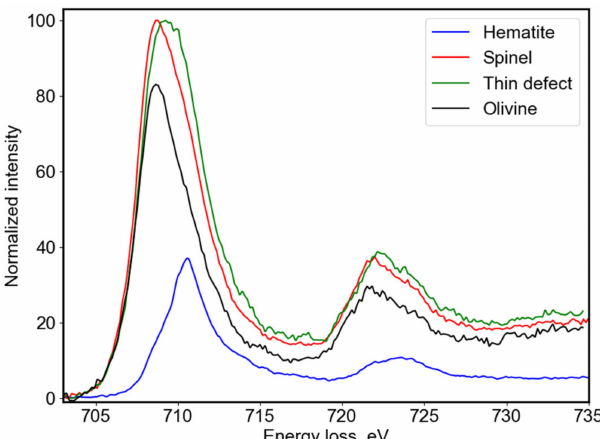
Figure 5. The energy loss near edge structures (ELNES) spectra at Fe-L 3,2 edge for the thin planar defect (green line), the thicker platelet with spinel structure (red line), the olivine matrix (black line), and a reference spectrum for hematite (blue line). In order to provide direct comparison, the spectra were extracted from spectrum images with a size of 172 per 5 px containing both host olivine and the two types of defects. The presented spectra are a sum of 28 px for the thick spinel platelet (red line) and the olivine matrix (black line) and 20 px for the thin planar defect (green line). These ELNES structures reveal a slight change of the Fe oxidation state within both features, the platelet with the spinel structure, and the thin planar defect. The olivine iron is in Fe 2+ oxidation state and it becomes slightly Fe 3+ within the thicker spinel platelet. The change to Fe 3+ is more strongly pronounced in the thin planar defects. For hematite, Fe is in trivalent oxidation state. The ELNES spectra for the olivine and hematite were used to obtain the Fe 3+ / Σ Fe ratio for both features. These reference spectra are plotted with their corresponding spectral contributions needed to obtain the best fit for the thin planar